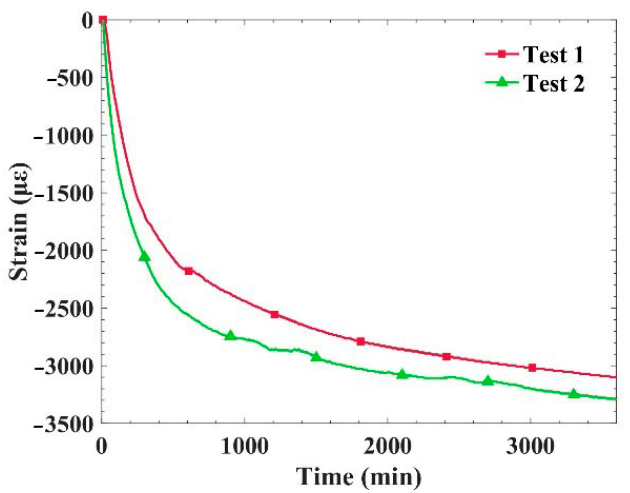
Figure 3. The strain of the PCB during the curing process of the potting adhesive.